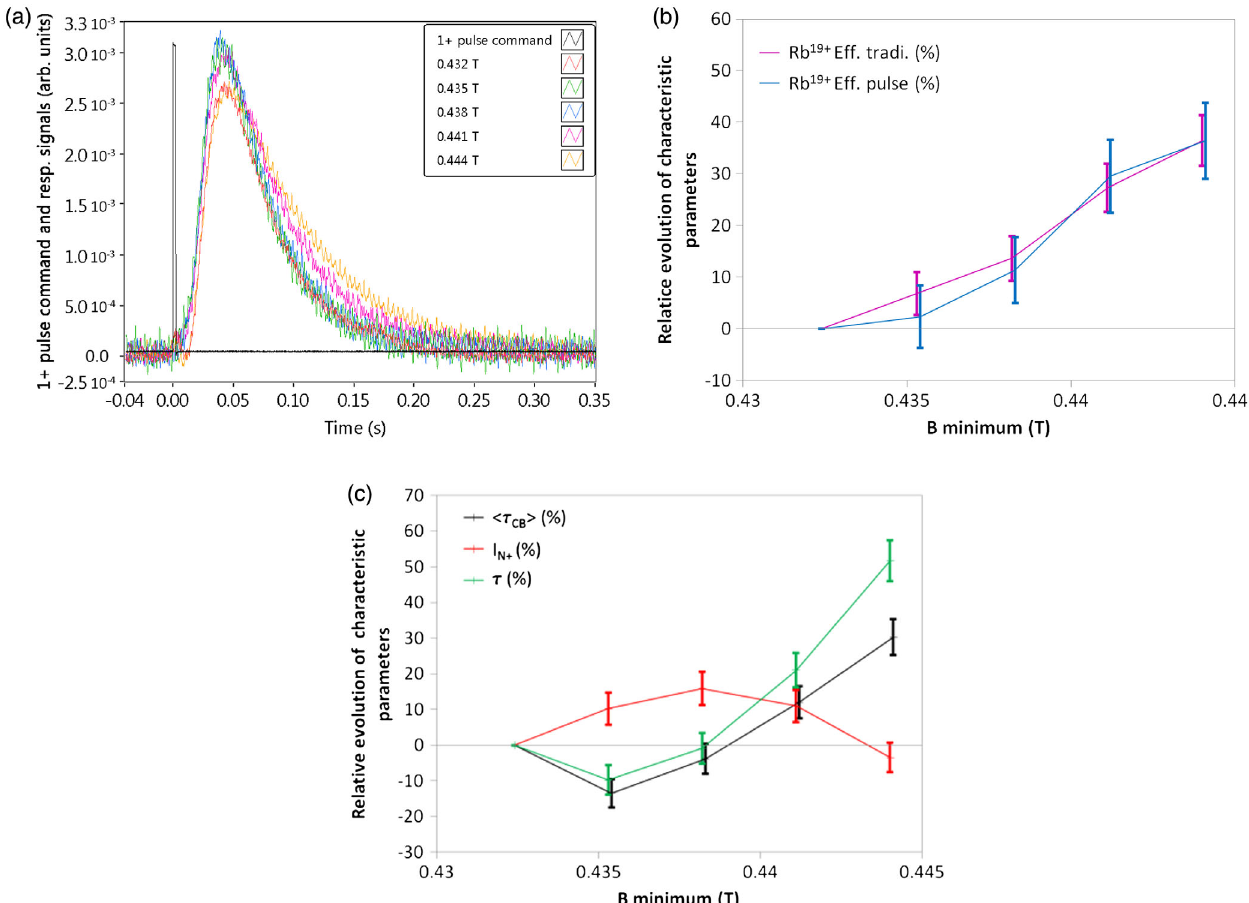
FIG. 8. (a) Rb 19 þ signal responses at several median coil currents. (b) Variation of the Rb 19 þ efficiency as a function of the median axial field. (c) Variation of the time characteristics and maximum current as a function of the median axial field. (b), (c) Relative uncertainty on the estimated B minimum field plotted on the x axis is evaluated at (cid:2) 0 . 5